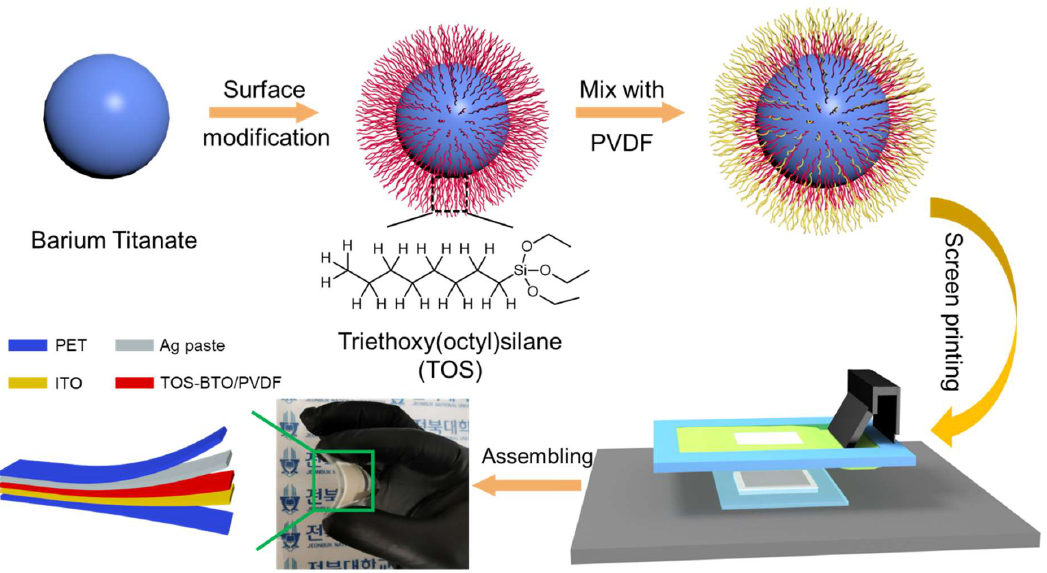
Figure 1. Schematic of the fabrication of the screen-printed TOS-BTO/PVDF piezoelectric sensor.